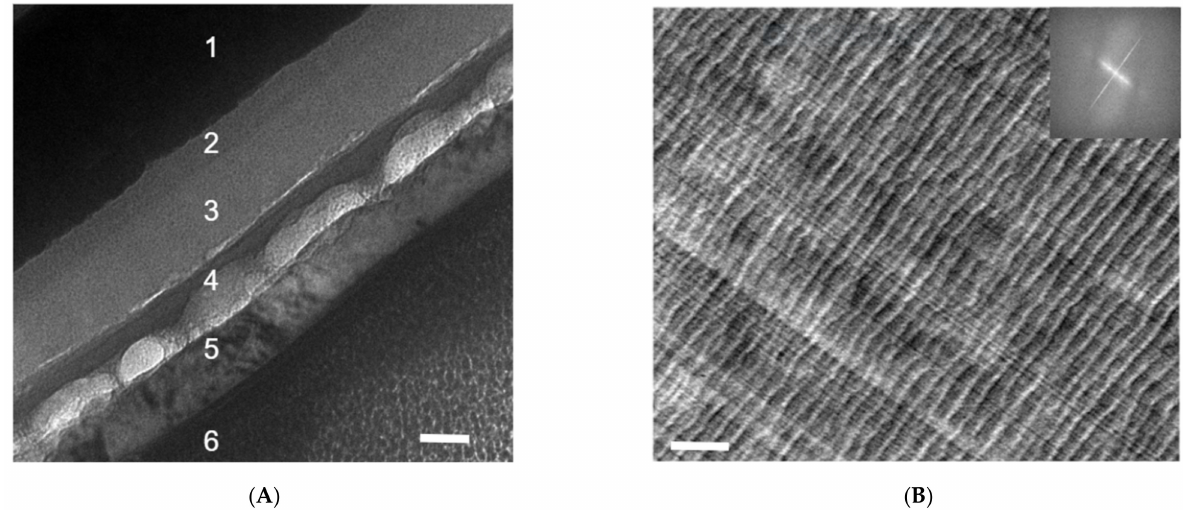
Figure 2. ( A ) A cross-sectional TEM image of an organic solar cell processed by FIB. Layers 1–6 correspond to (1) indium tin oxide (ITO), (2) spin-coated poly(3,4-ethylenedioxythiophene) polystyrene sulfonate (PEDOT:PSS) layer, (3) low-bandgap polymer/PCBM composite layer, (4) calcium layer, (5) aluminum electrode, and (6) platinum protection layer for FIB sample preparation. The black-dotted structures on layers 2 and 3 are likely caused by a polishing current that is to be reduced during FIB sample preparation. The polishing also causes delamination between layers 3 and 4, as well as an uneven thickness of layer 4. The scale bar is 50 nm. This is an unpublished result related to a previously published work [21] ( B ). Wavy microstructures of microtomed PBI films and the cutting lines that are vertical to them. A fast Fourier transformation (FFT) of the left TEM image is presented on the right. The straight thin lines running from top left to bottom right are the results of the non-smooth diamond knife edge, and the wavy curves vertical to them with larger spacings result from the intrinsic mechanical instability of the film. The scale bar is 200